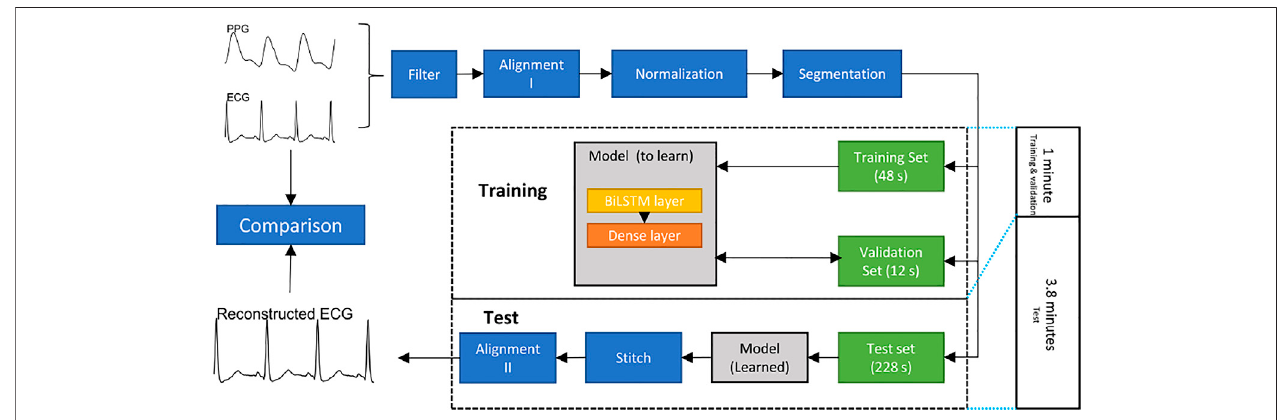
FIGURE 2 | Flowchart of constructing an electrocardiogram (ECG) signal from a photoplethysmogram (PPG) signal. The bidirectional long short-term memory (BiLSTM) model is trained and validated for 1 minute to generate 3.8 min ECG signal.